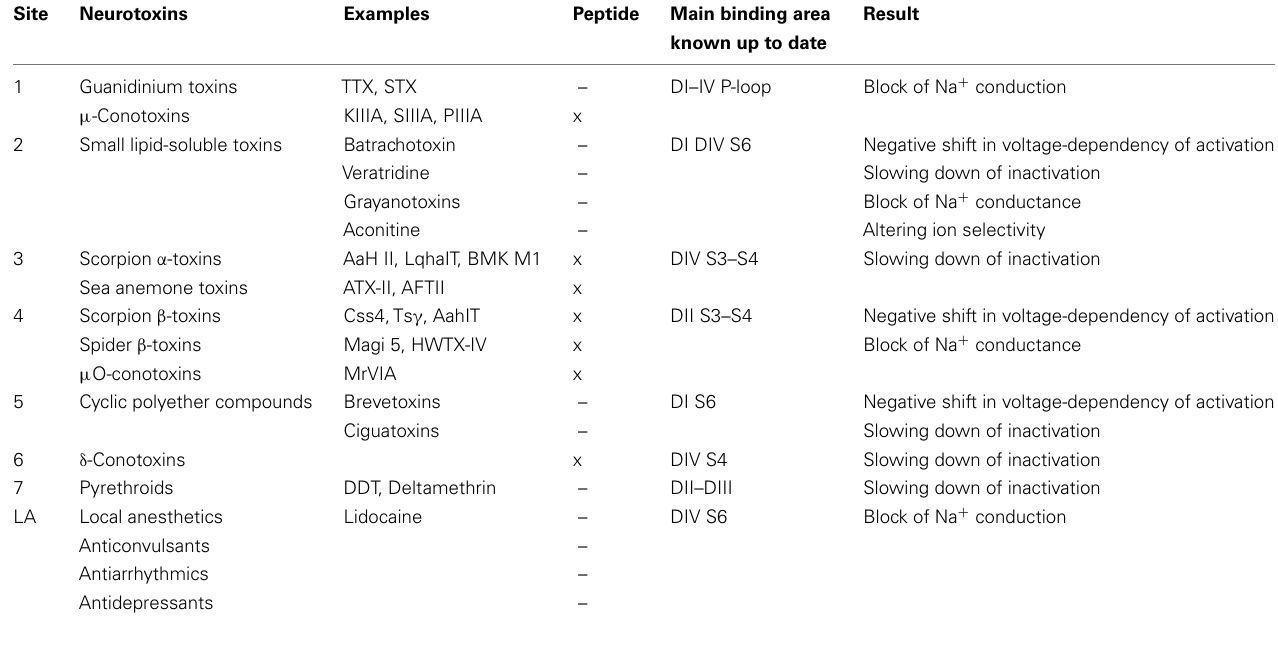
Table 1 | Overview of neurotoxin binding sites according to the revised